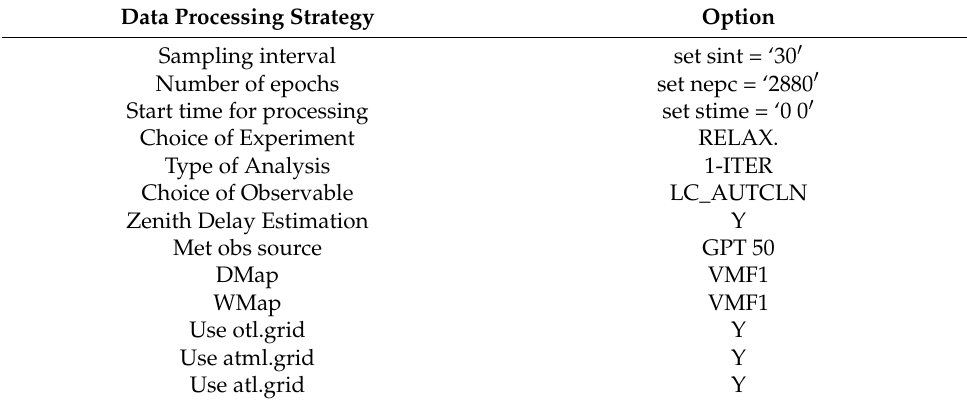
Table 1. Data processing strategy.